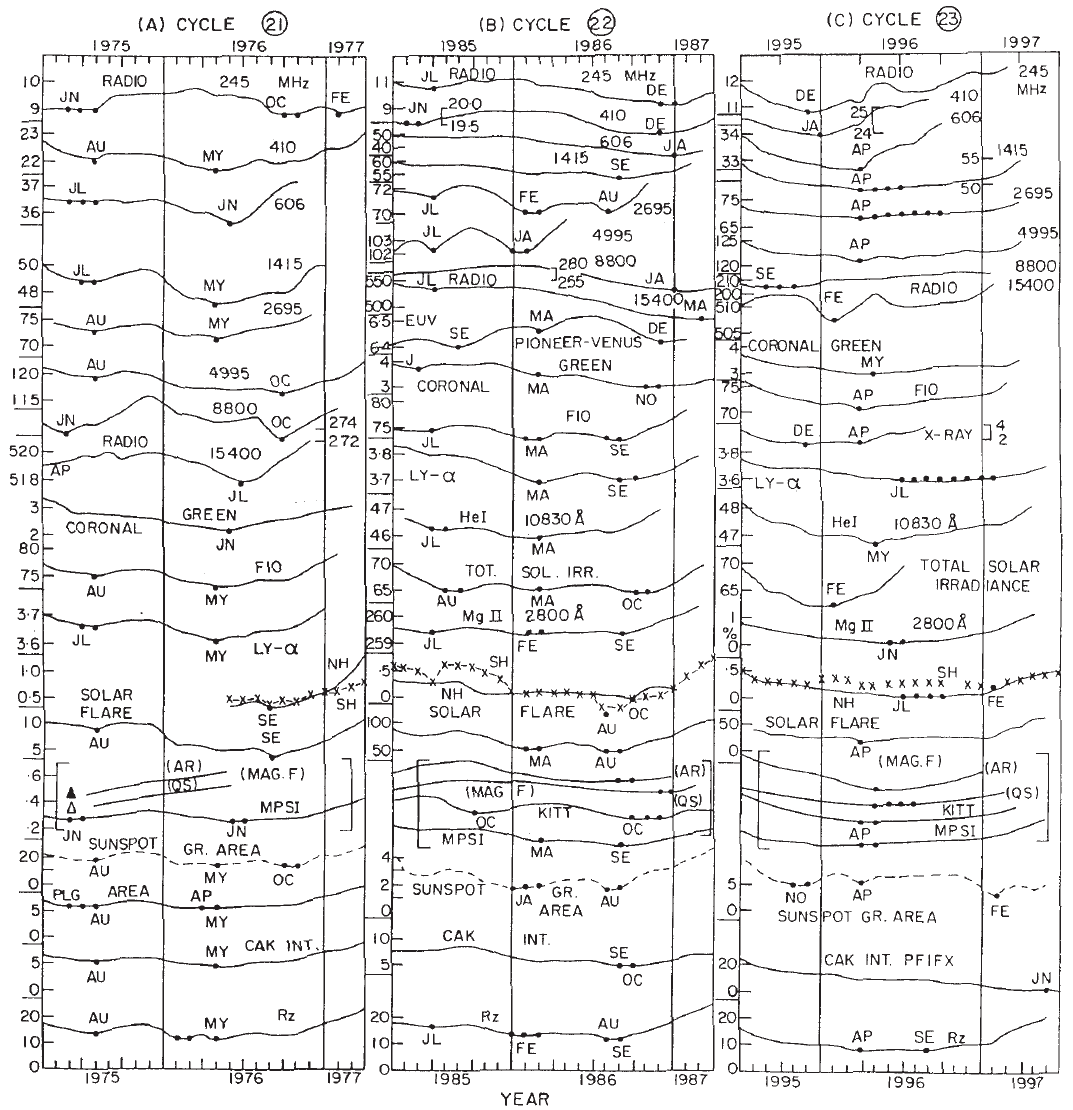
Fig. 10. Plots of the 12-month moving averages of various indices during years of sunspot minima of (A) cycle 21, 1975–1977, (B) cycle